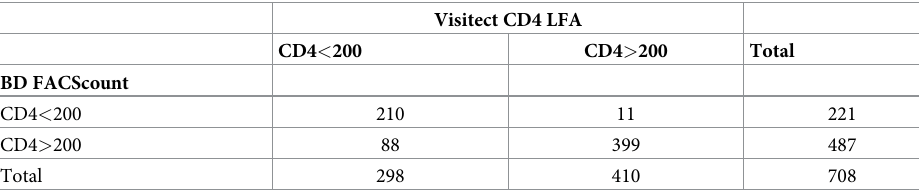
Table 2. Contingency table of Visitect CD4 LFA test results with BD